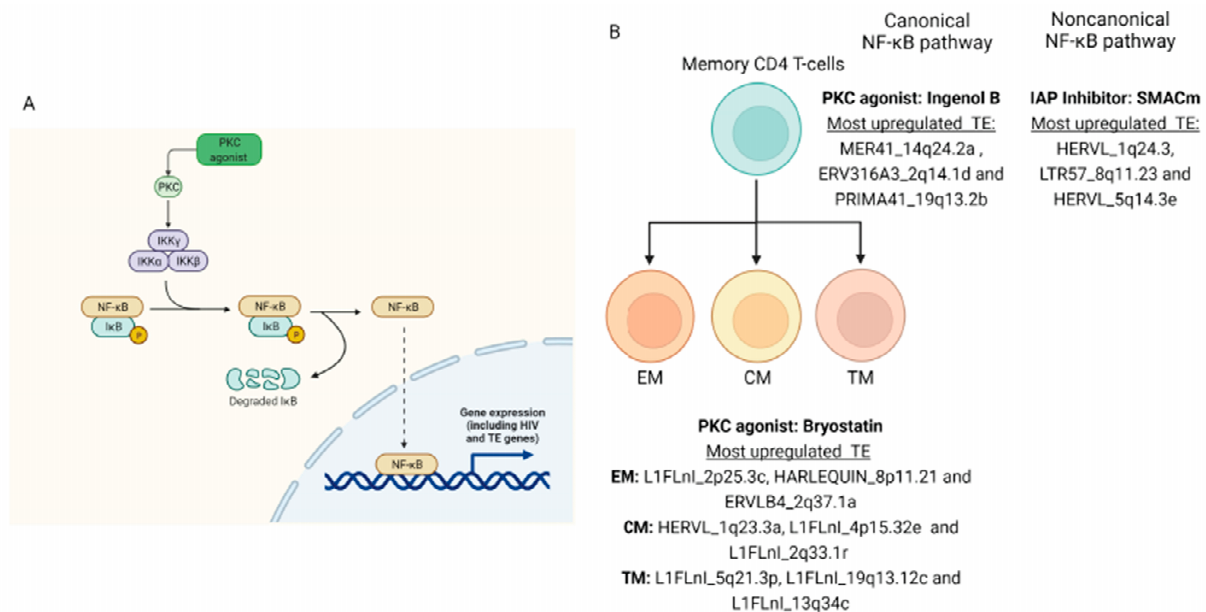
Figure 4. TE expression by PKC LRA. ( A ) Canonical NF- κ B pathways lead to TE expression in the PKC activation during HIV shock and kill strategy and ( B ) most differential TE expressed in memory CD4+ T cells.